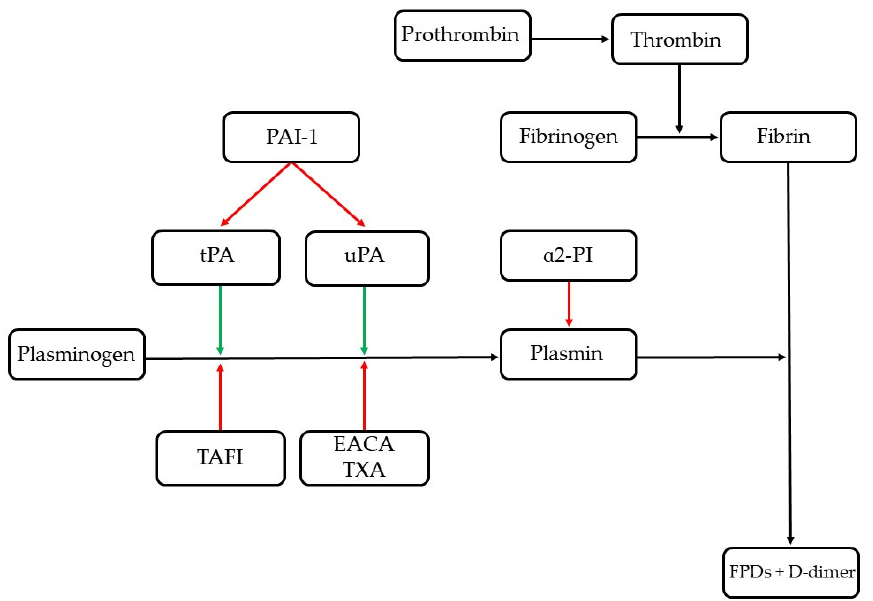
Figure 1. Fibrinolysis overview. The red arrows indicate inhibition; the green arrows indicate stimulation. α 2-PI, α 2-plasmin inhibitor; EACA, epsilon aminocaproic acid; FDPs, fibrin/fibrinogen degradation products; TAFI, thrombin-activatable fibrinolysis inhibitor; tPA, tissue plasminogen activator; TXA, tranexamic acid; uPA, urokinase plasminogen activator.